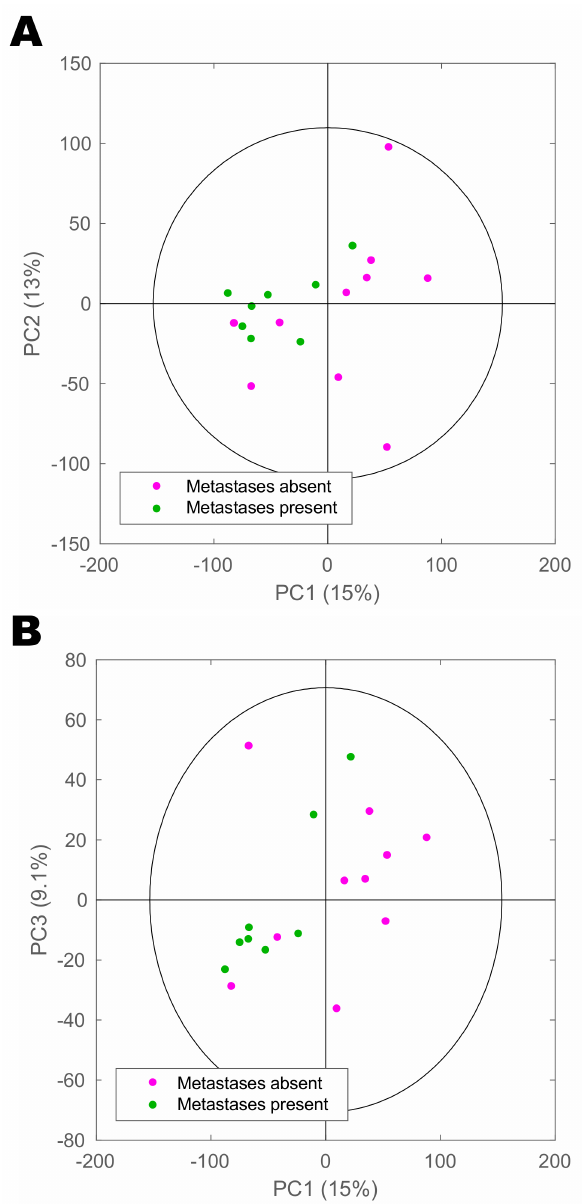
Figure 5. Scores plot of cross-validated principal component analysis model of spectra from PanNEN patients with and without any metastases. ( A ) Component 1 vs. 2; ( B ) Component 1 vs.